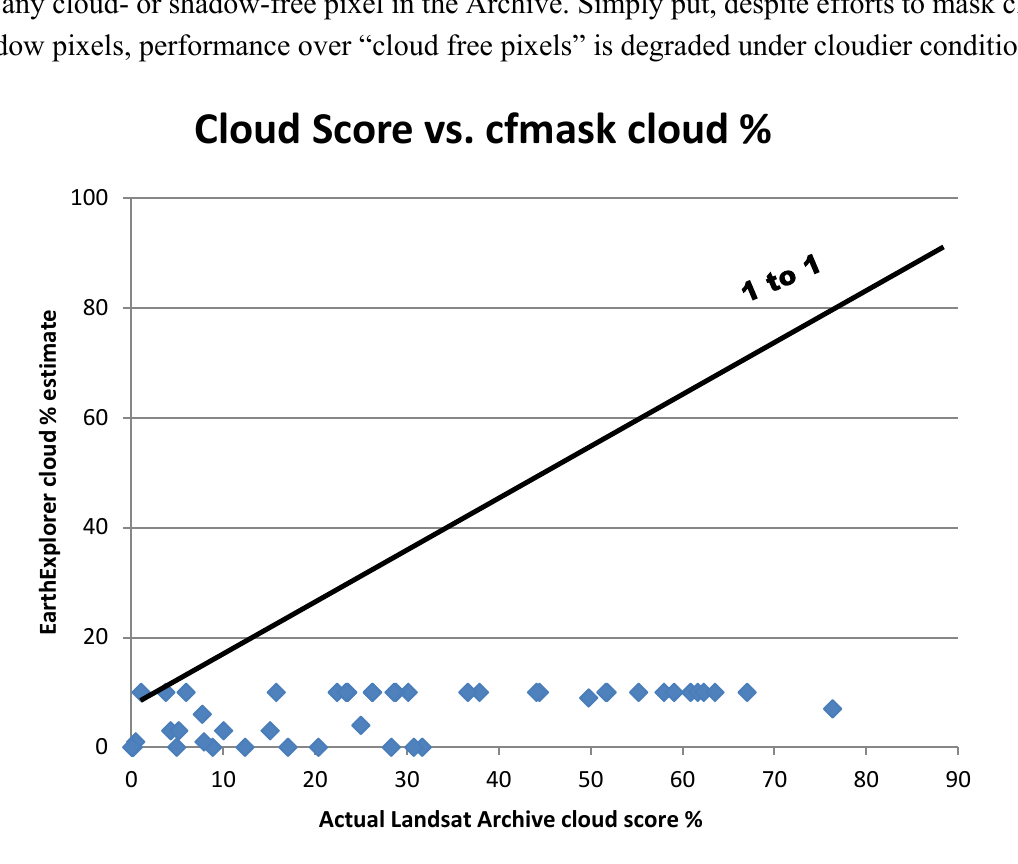
Figure 8. Landsat cloud scores attributed to scenes in Earth Explorer (Y-axis) versus percent of the EDEN study domain covered by clouds on the corresponding image date as calculated for Landsat Surface Reflectance provisional data generation. This demonstrates both the inaccuracy of the information accessed when querying Earth Explorer and the broad range of actual cloudiness represented by the study input